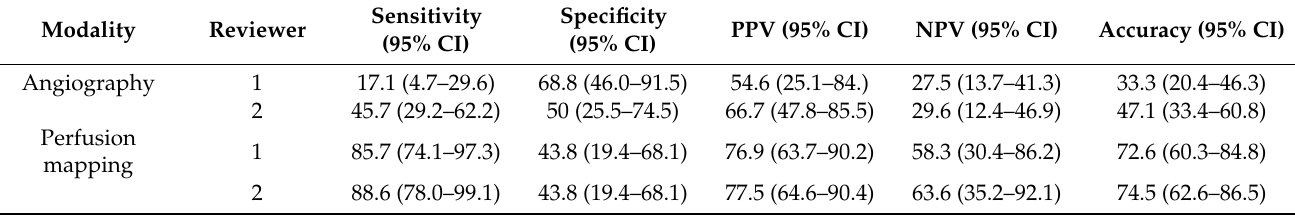
Table 4. Diagnostic performance of clinical outcome evaluation after percutaneous transluminal angioplasty.